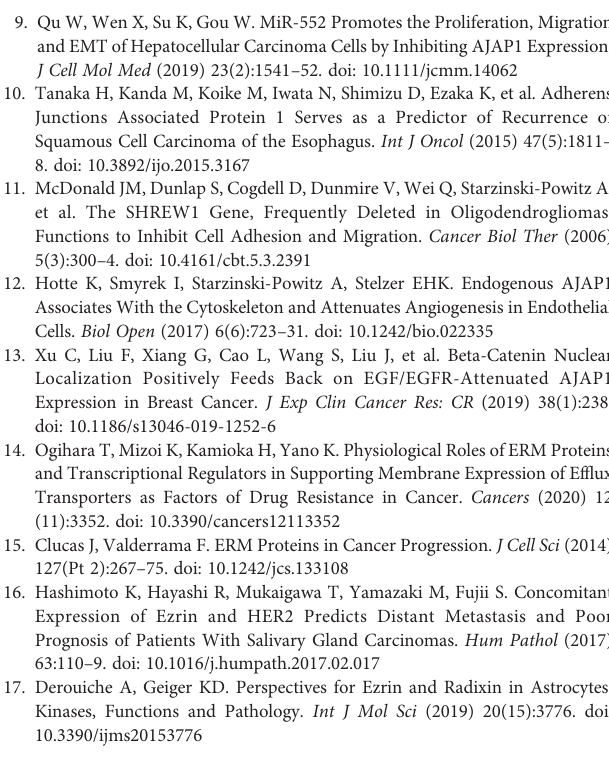
Supplementary Figure 1 | qRT-PCR results of AJAP1 expression in Ezrin overexpressed MDA-MB-231 cells and Ezrin-silenced T47D cells. N.S., no signi fi